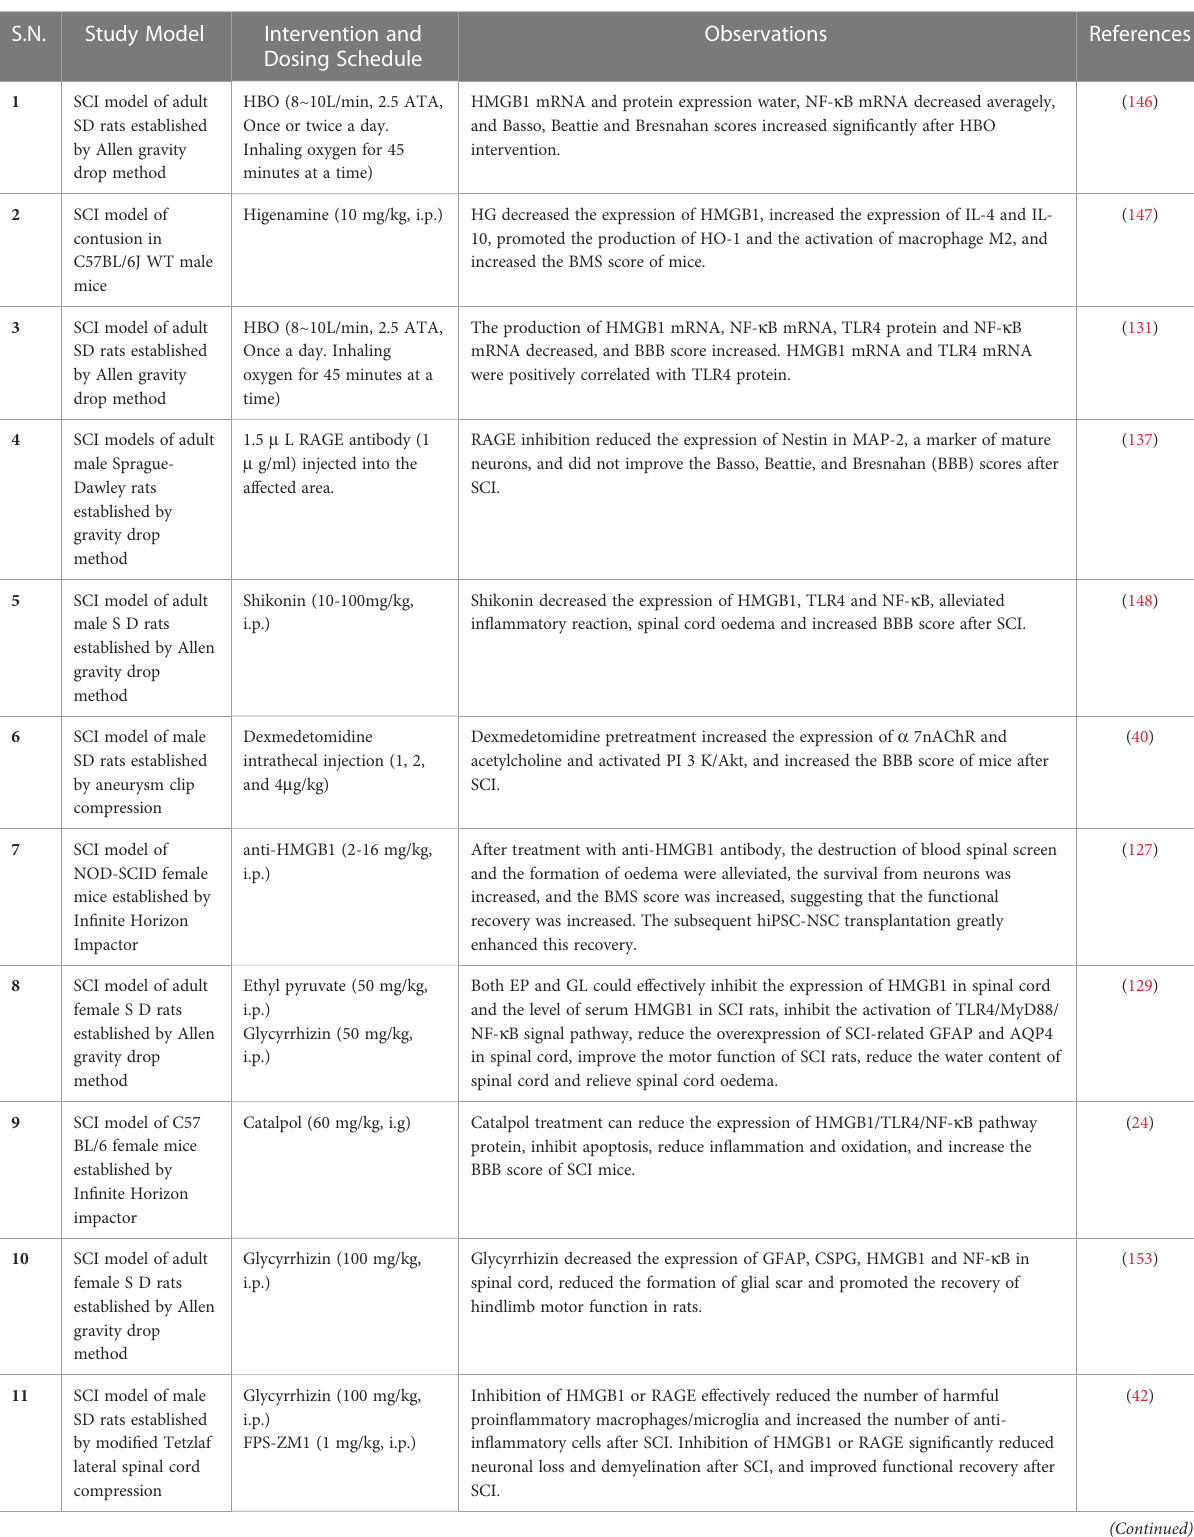
TABLE 1 Summary of targeted HMGB1 treatment of SCI.